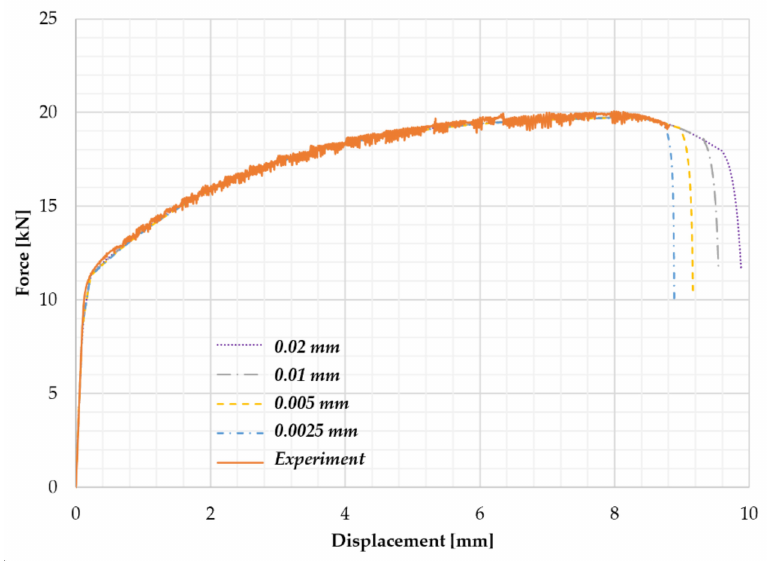
Figure 8. Sensitivity study of a staggered scheme for various displacement